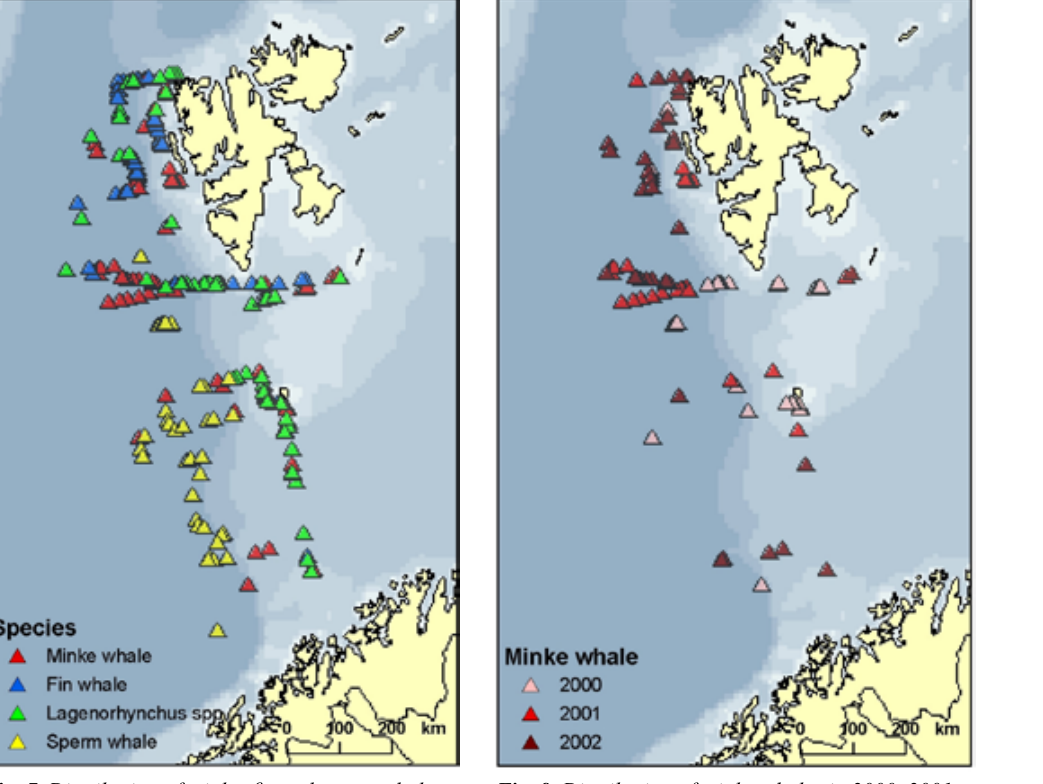
Fig. 7. Distribution of minke, fin and sperm whales, and Lagenorhynchus dolphins, observed in 2000, 2001 and 2002.